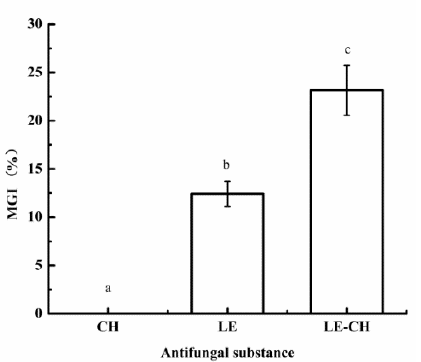
Figure 7. Effect of chitosan on the inhibition of Fusarium graminis by Litsea cubeba oil emulsion. CH represents chitosan solution, LE represents Litsea cubeba oil primary emulsion, and LE-CH represents Litsea cubeba oil secondary emulsion.